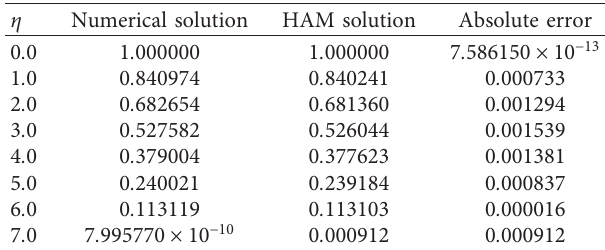
Table 2: Numerical solution via the analytical solution for the temperature θ ( η ) profile.